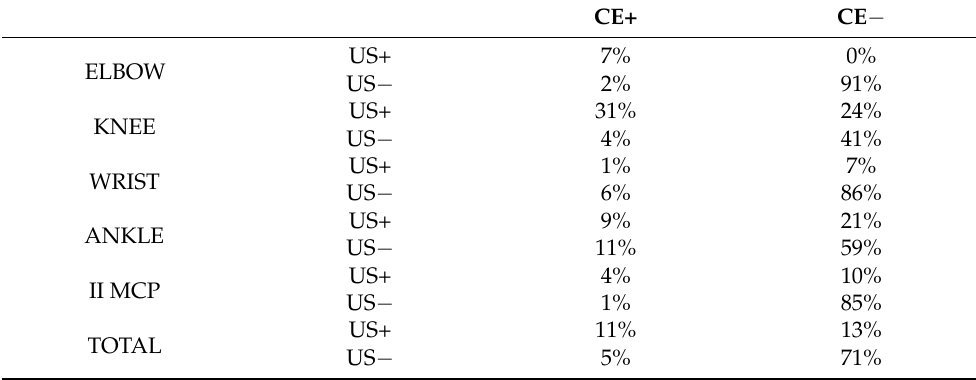
Table 2. Joints with synovitis at clinical examination (CE) and/or at the MSUS (US). Numbers are expressed as % of total joints assessed. US, ultrasound; CE, clinical examination; MCP metacarpopha- langeal joint. In bold are expressed significant p